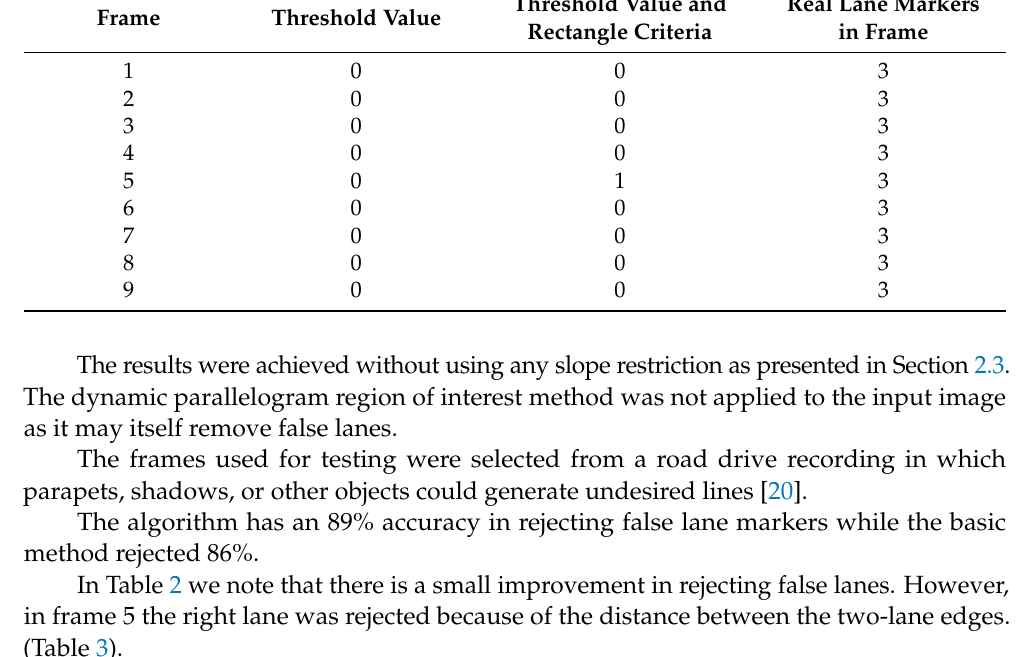
Threshold Value and Real Lane Rectangle Criteria